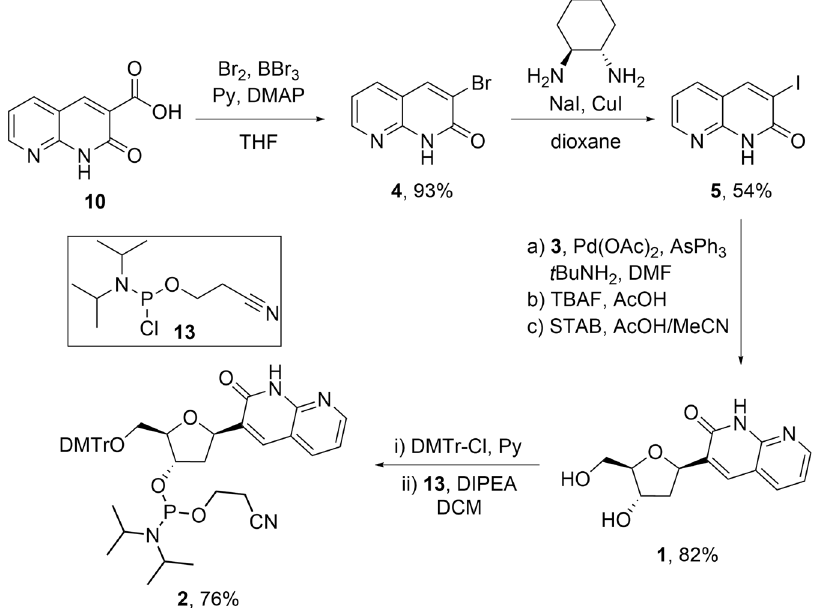
Figure 3. Synthesis of the phosphoramidite nucleoside of bT ( 2 ).